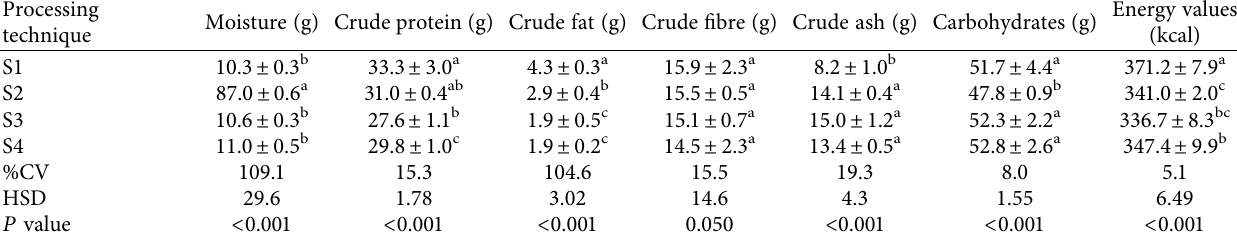
Table 1: Proximate composition of traditional preserved cowpea leaves (per 100g/dmb).